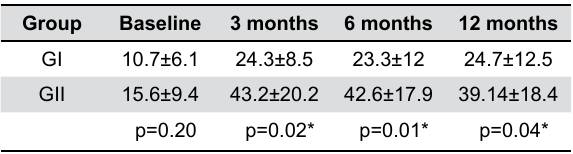
Table 4- Masticatory performance (%) among patients with mandibular overdentures supported by one (GI) or two (GII) implants. Comparison between the groups (mean±standard deviation)